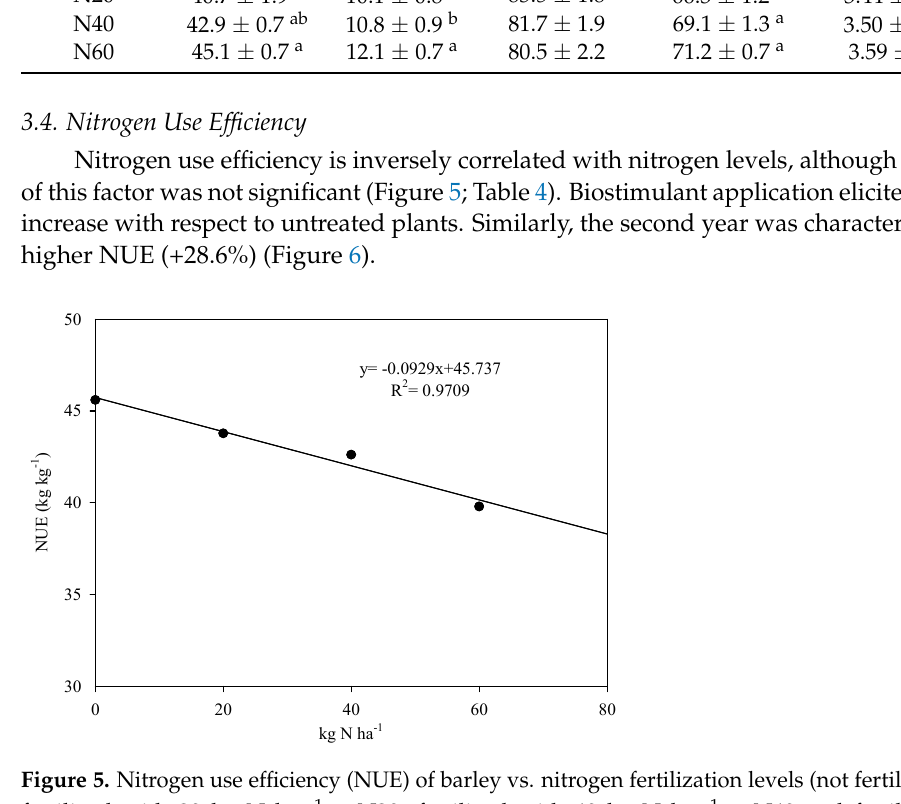
Figure 6. Nitrogen use efficiency (NUE) of barley as affected by growing season (2018–2019 = I Year; 2019–2020 = II Year), biostimulant (treated with biostimulant = Bio and not treated = Control). Dif- ferent letters indicate significant differences according to Duncan’s test ( p < 0.05). 4. Discussion Globally, beer consumption is greater than wine and other alcoholic drinks, espe- cially in terms of volume, but it is lower in terms of economic value due to the lower market price of beer with respect to other beverages [3]. Barley is the primary matrix for the malting process; therefore, the increase in beer consumption is closely linked with an increase in barley cultivation. Between 2014 and 2020, the total cultivated area for barley production increased by about 15% in Italy [53]. However, the increase in cultivated areas